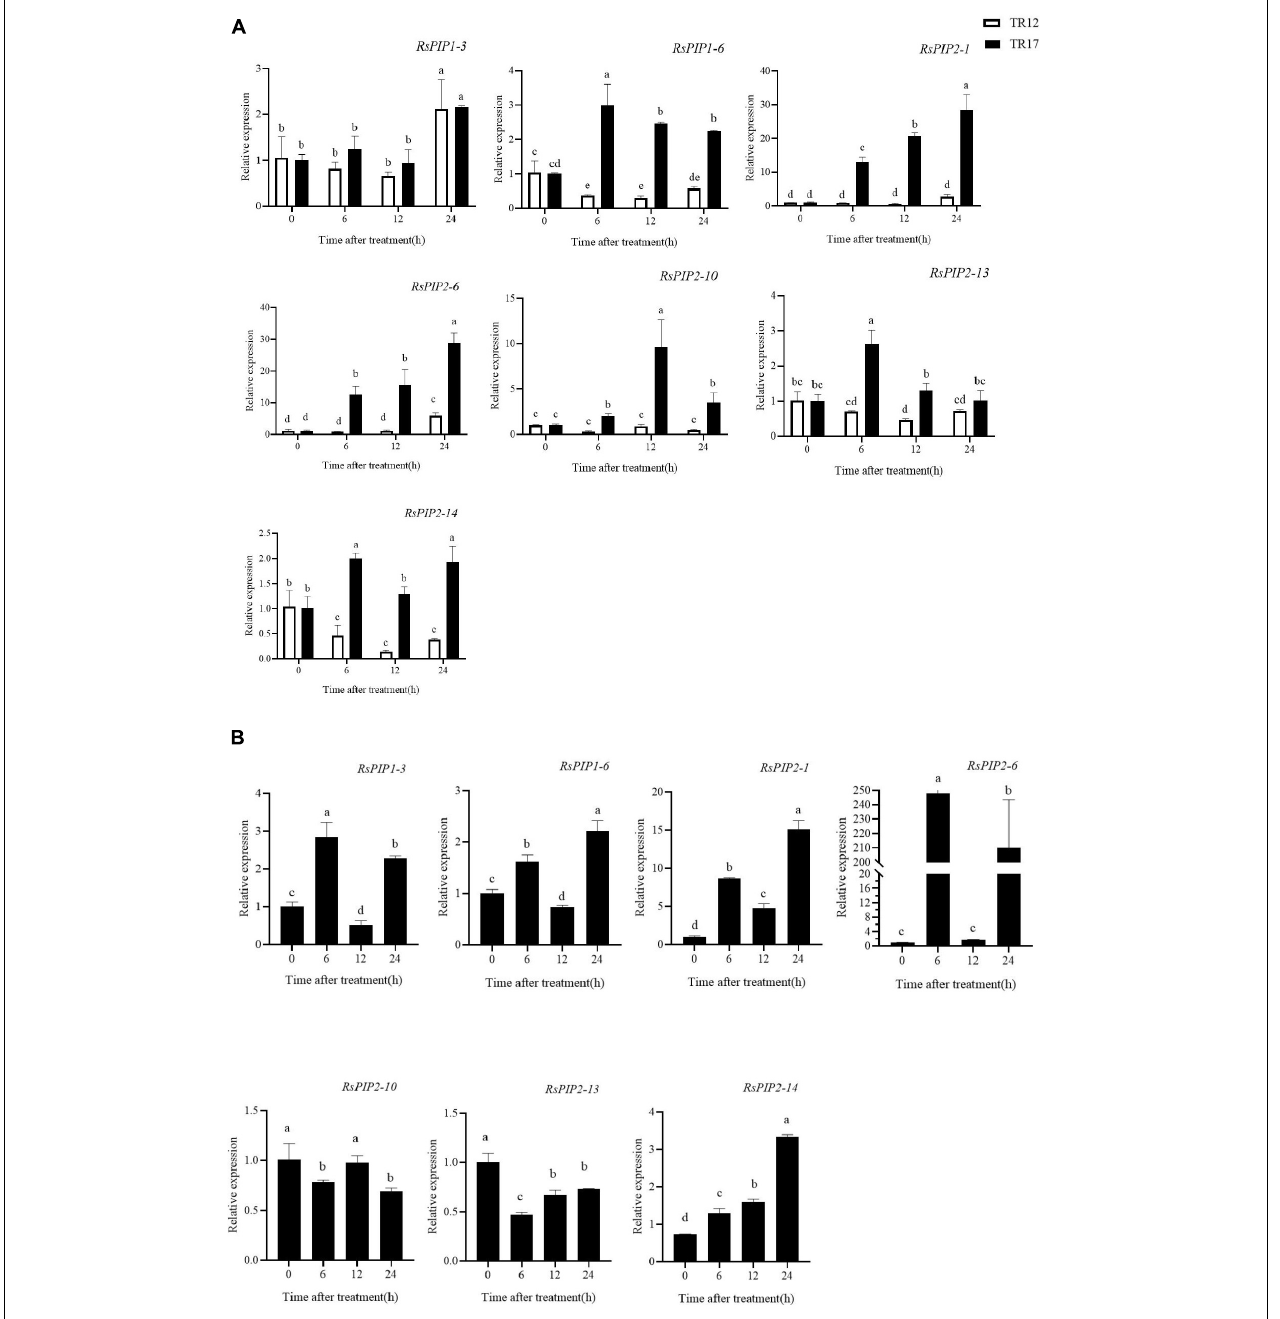
FIGURE 6 | Expression levels of RsPIP genes under NaCl treatment in young roots and the taproot thickening period. (A) Expression levels of RsPIP genes in young roots for the indicated time (h) under 150 mM NaCl treatment. (B) Expression levels of RsPIP genes in the taproot thickening period for the indicated time (h) under 150 mM NaCl treatment. RsActin was used as an internal control for qRT-PCR. The relative expression levels of the RsPIP genes were calculated based on the comparative threshold cycle (Ct). Statistical analysis was processed using GraphPad Prism 8. The significant difference was analyzed using IBM SPSS Statistics 25, values with different lowercase letters indicate a significant difference at p < 0.05 according to Duncan’s multiple range tests. Each bar shows the mean ± SE of the triplicate assay.